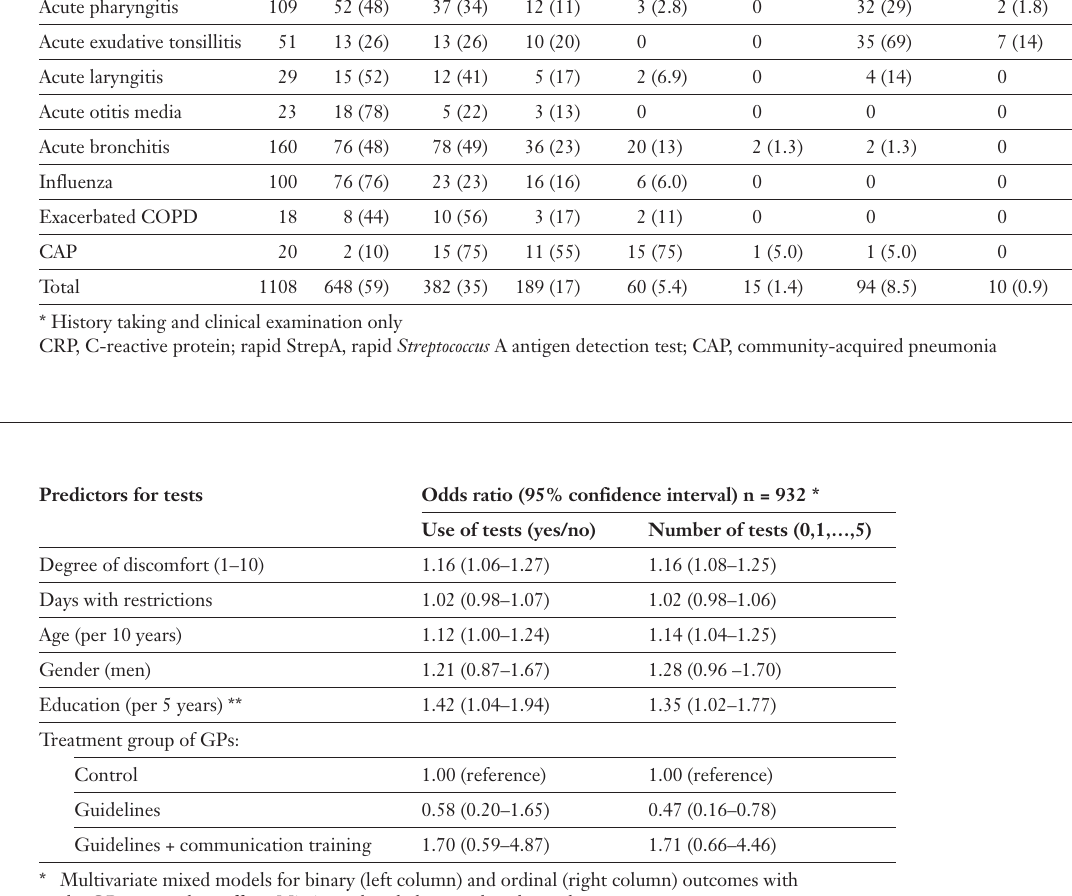
Prevalence of diag- nostic tests for ARTI in a clinical trial.